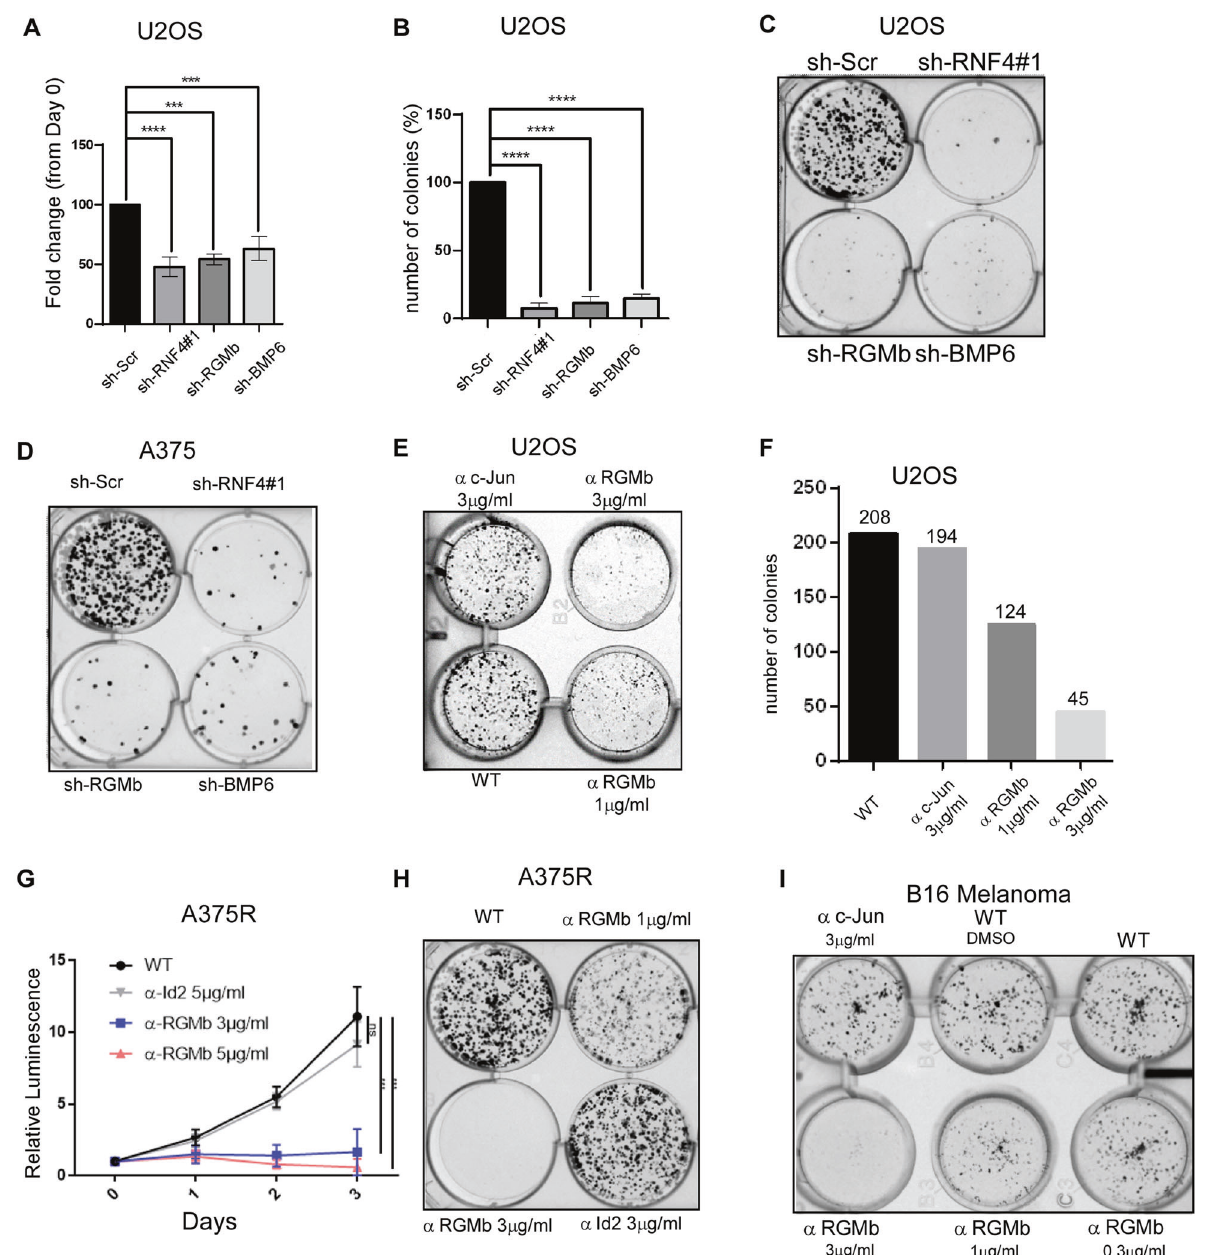
Fig. 4 RNF4, BMP6, and RGMb are essential for cancer cell survival and tumor-sphare formation. A – C shRNA-mediated knockdown of the indicated genes, but not scrambled control (sh-Scr), inhibits cell proliferation ( A ) and sphere formation ( B , C ) of human osteosarcoma U-2-OS cells. Cell proliferation was measured indirectly by ATP-Lite assay and in both A and B n = 3 and **** p < 0.001 ( C ) is a representative experiment of ( B ). D shRNA-mediated knockdown of the indicated genes, but not scrambled control (sh-Scr), inhibited sphere formation of human A375 melanoma cells. Quanti fi cation of the experiment shown in Supplemental Fig. 4B. E , F Sphere formation of human U-2-OS osteosarcoma cells is inhibited by the addition of α -RGMb, but not by the addition of control antibody ( α -c-Jun) to the culture media, in a dose-dependent manner. Quanti fi cation of the experiment is shown in F . G , H Proliferation ( G ) and sphere formation ( H ) of human, PLX-4032- resistant melanoma cells (A375R), are inhibited by the addition of α -RGMb, but not by the addition of control antibody ( α -Id2) to the culture media, in a dose-dependent manner, n = 3 *** p < 0.001. I Sphere formation of mouse B16F10 melanoma cells is inhibited by the addition of α - RGMb, but not by the addition of control antibody ( α -c-Jun) to the culture media in a dose-dependent manner. Statistics was calculated by one-step ANOVA Graph-prism